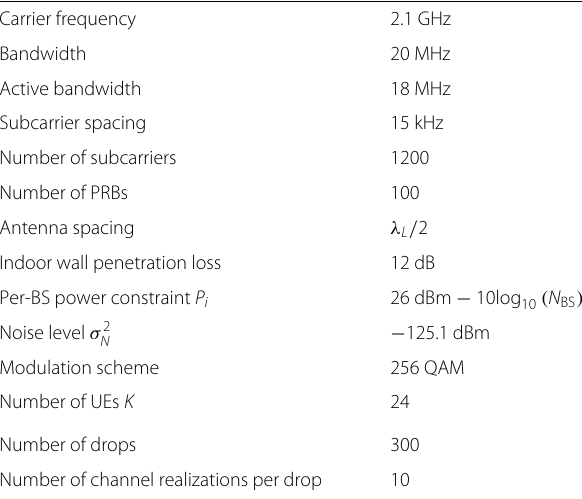
Table 1 Simulation